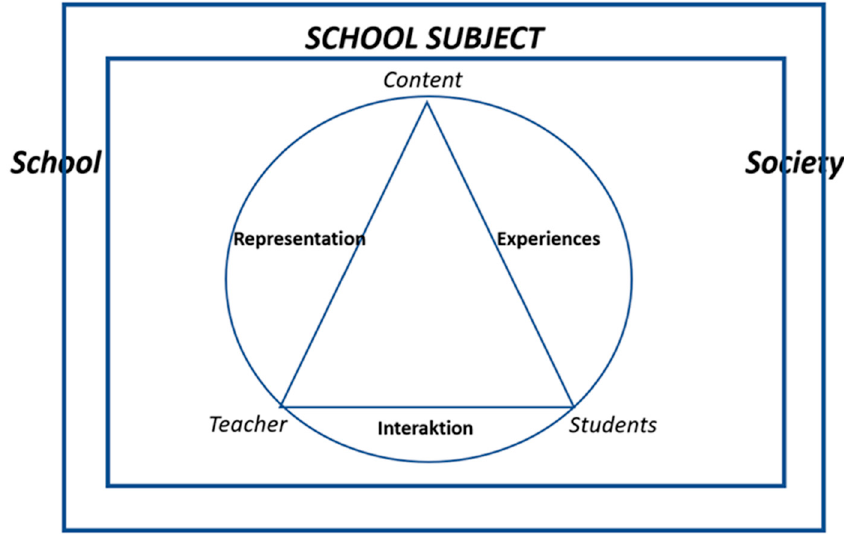
Figure 1. The didactic triangle.